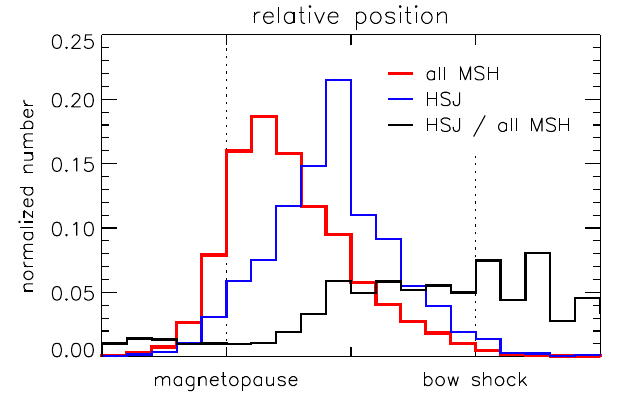
Fig. 2. Coverage of magnetosheath intervals (red), projected onto the GSE x - y plane. THEMIS positions at times t 0 (HSJs) are marked with blue crosses.